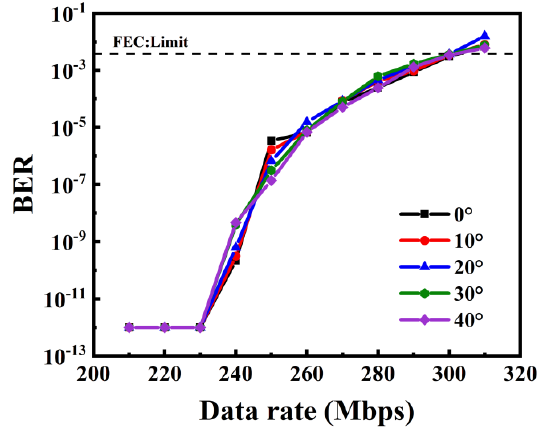
Figure 7. BER versus data rate at the total reflection angle of 0 ◦ to 40 ◦ .